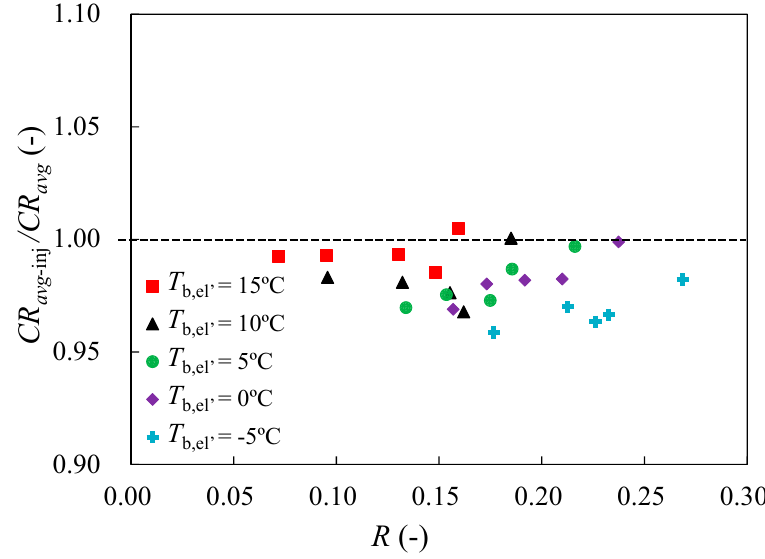
Figure 15. The normalized compression ratio C R avg-inj / CR avg with injection ratio R in the vapor injection heat pump cycle.